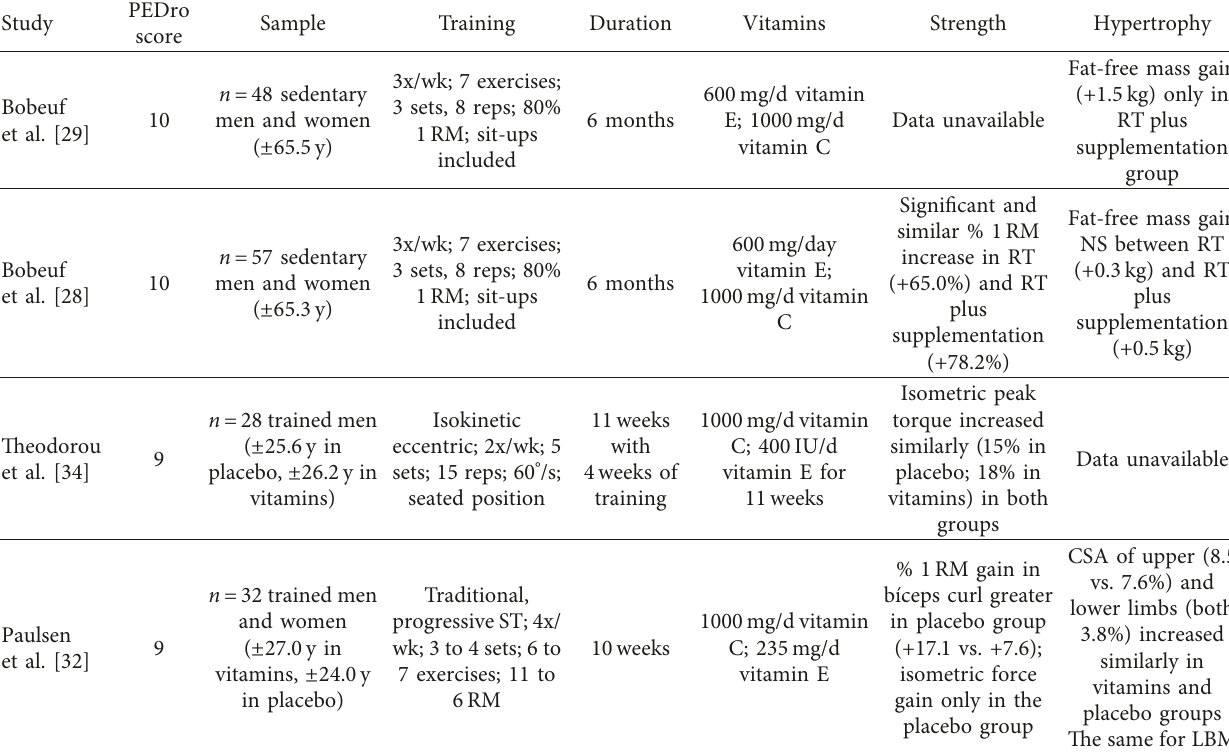
Table 1: Main characteristics and findings of the selected